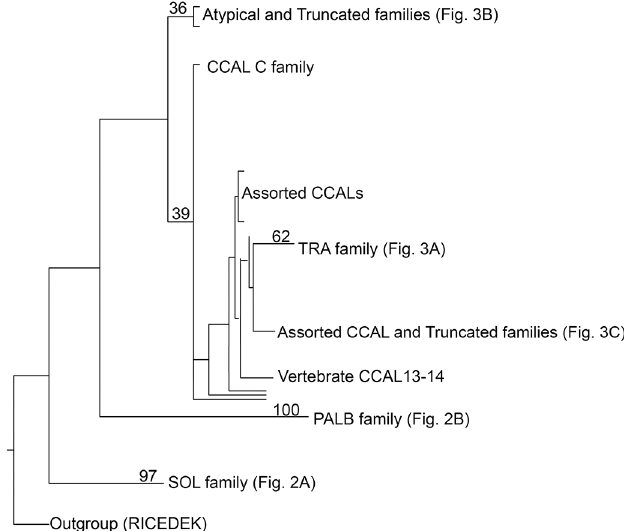
Fig 1. Phylogeny of calpain families. An overviewof the analysisof all Calpainfamilies is presented. The analysisis describedin the methods(the plot is from the RAxML analysis).Numbers represent the percentage of trees containing this phylogeny. Regionsof the tree are expandedin the figures noted. The vertebrate CCAL 13–14 family, CCAL C family and assorted CCALs are examinedmore fully later in the paper. The full tree can be seen in S2